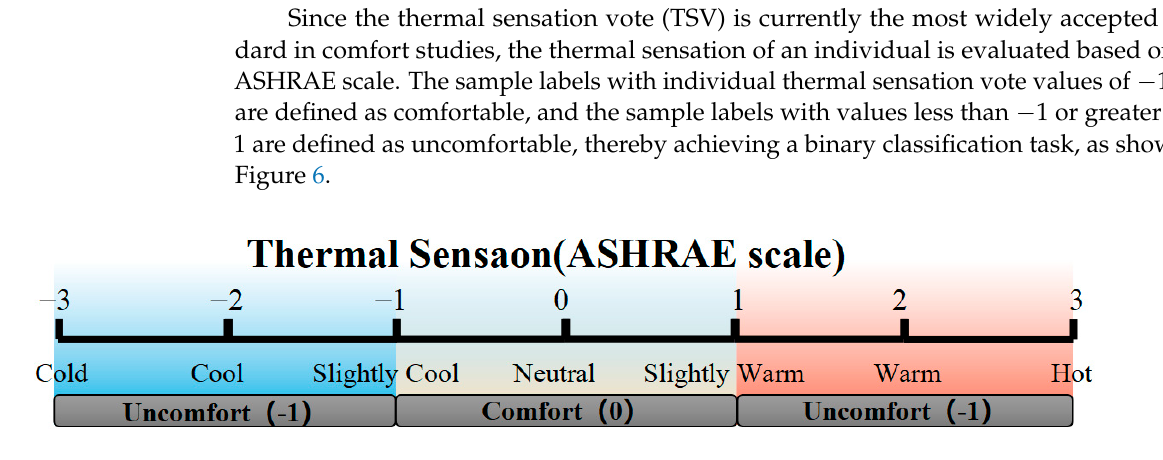
Figure 6. Schematic diagram of Thermal Sensation classification.